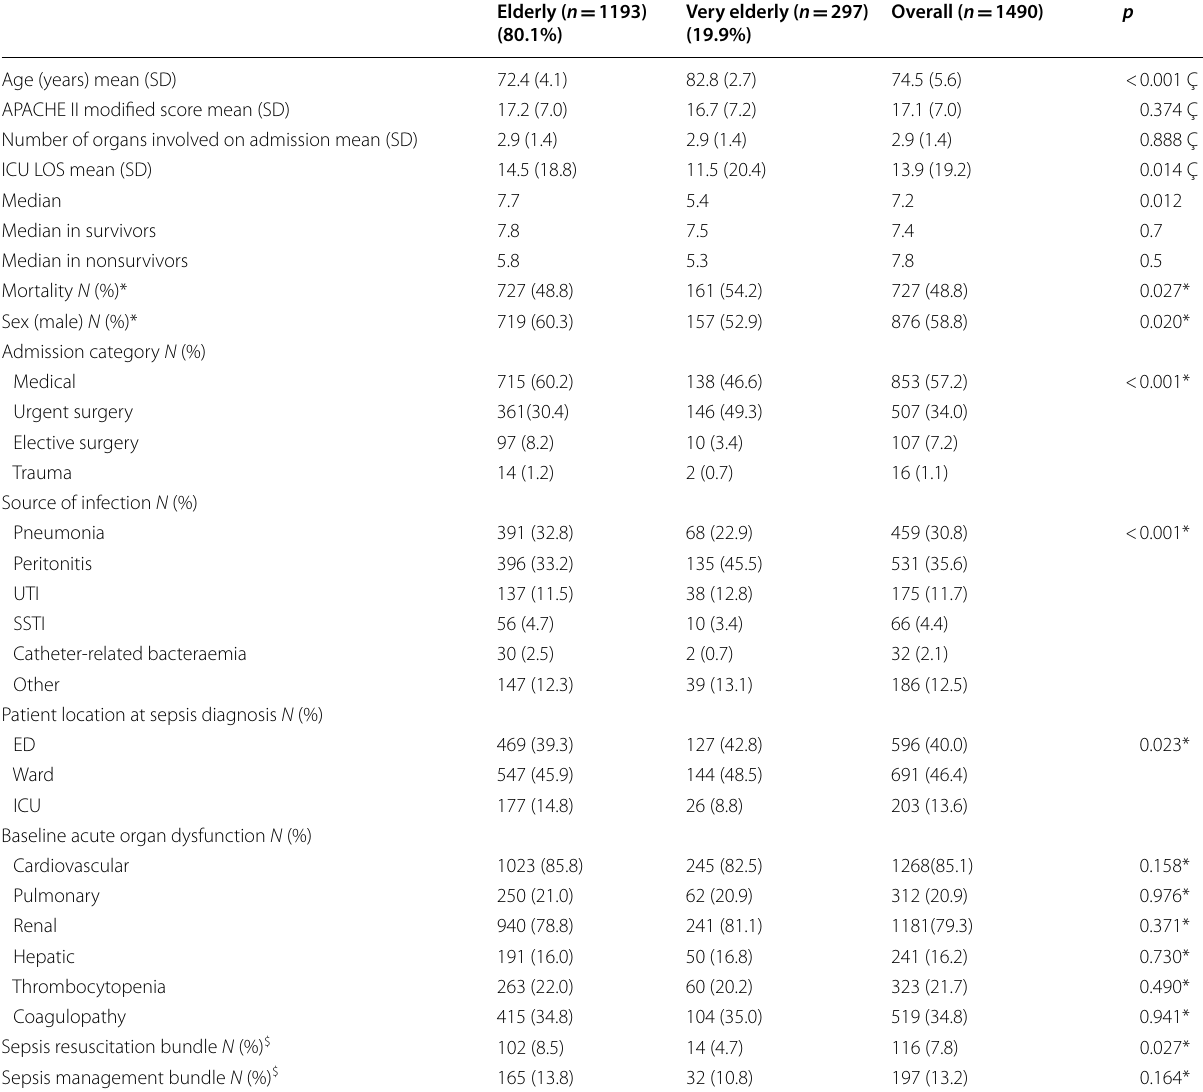
Table 1 Comparison of baseline characteristics between elderly and very elderly